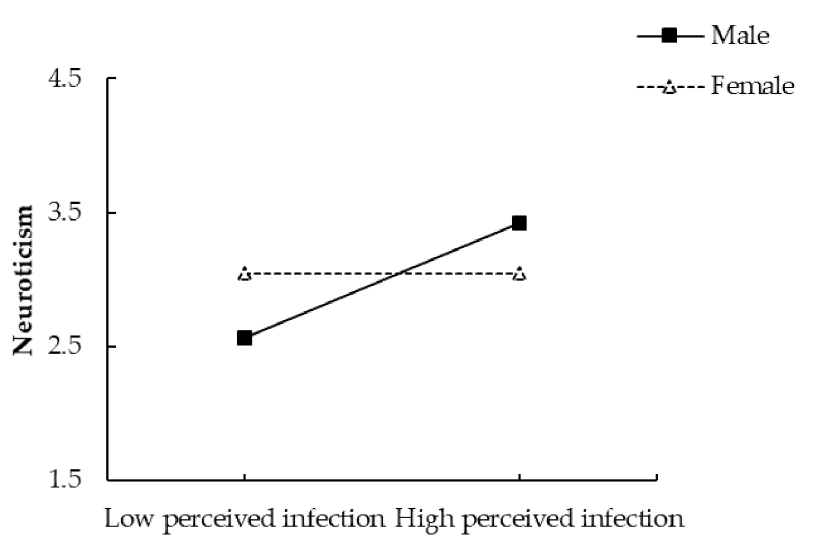
Figure 1. Gender as a moderator for the relationship between perceived infection and neuroticism. Similarly, the interaction between perceived infection and gender was also significant for on-line aggression, β = 0.40, SE = 0.11, t = 3.51, p < 0.001 (see Figure 2). Simple slopes analyses indicated that, for men, higher levels of perceived infection were associated with higher levels of aggression, β = 0.66, p < 0.001; for women, the link between perceived infection and aggression was also significant, but the magnitude was smaller, β = 0.26, p =